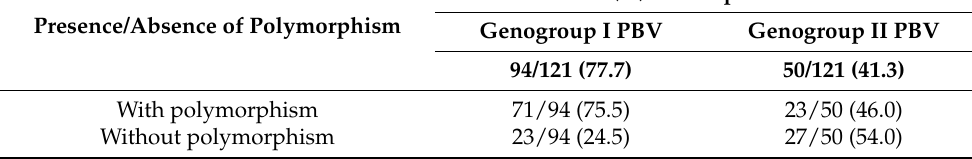
Table 1. Prevalence of genotype I and genotype II picobirnaviruses (PBVs) in 121 dromedaries positive for the presence of PBV as detected by RT-PCR of partial fragments of RNA-dependent RNA polymerase (RdRp) gene, and the number of positive PBV samples with and without the presence of nucleotide